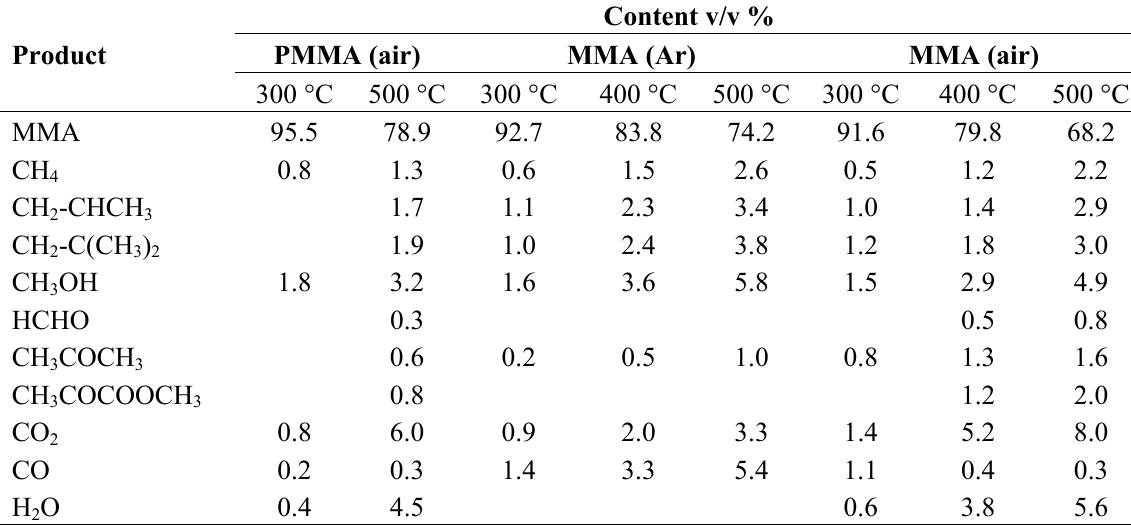
Table 12. The content of combustion products of PMMA and MMA in air and Ar at different temperatures